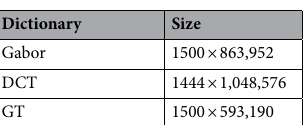
Table 2. The dictionary sizes. When built the DCT dictionary, perfect square was required for the column length, so the nearest perfect square 1444 around N was